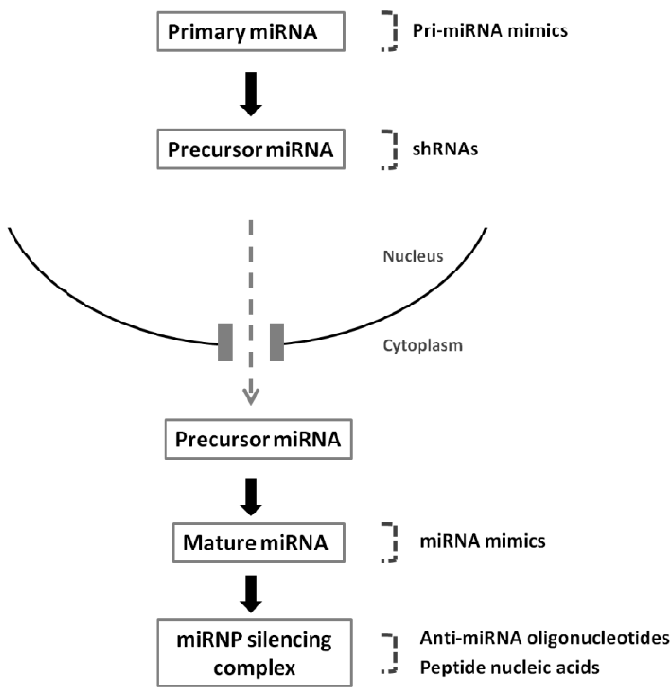
Figure 2. Strategies that are mostly employed to modulate miRNA expression. Constructs used to re-express or silence mature miRNAs: virally-mediated nuclear expression of pri-miRNA mimics or shRNAs, cytoplasmic delivery of double-stranded miRNA mimics, anti-miRNA oligonucleotides and peptide nucleic